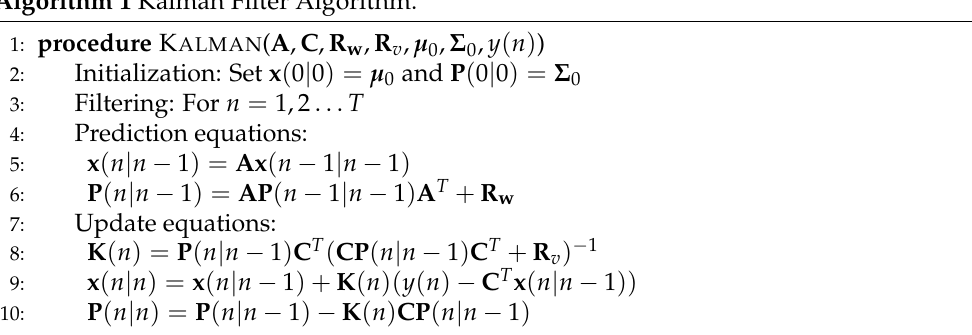
Algorithm 1 Kalman Filter